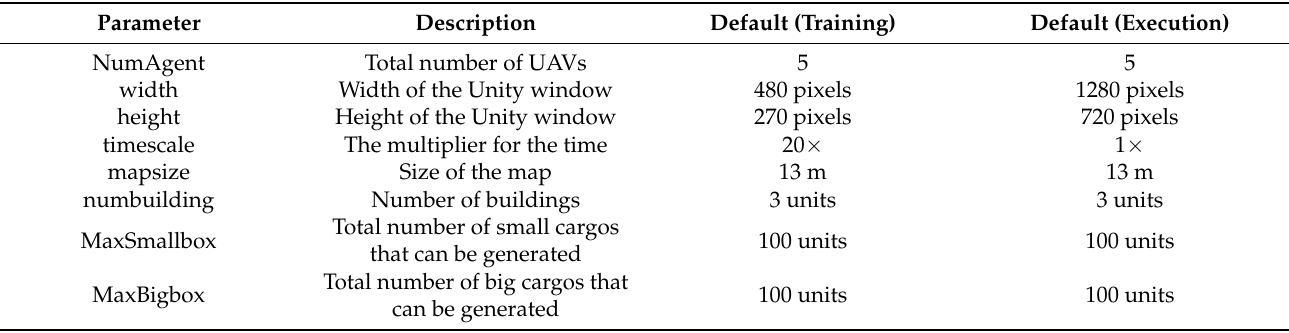
Table 4. Summary of environmental setup.